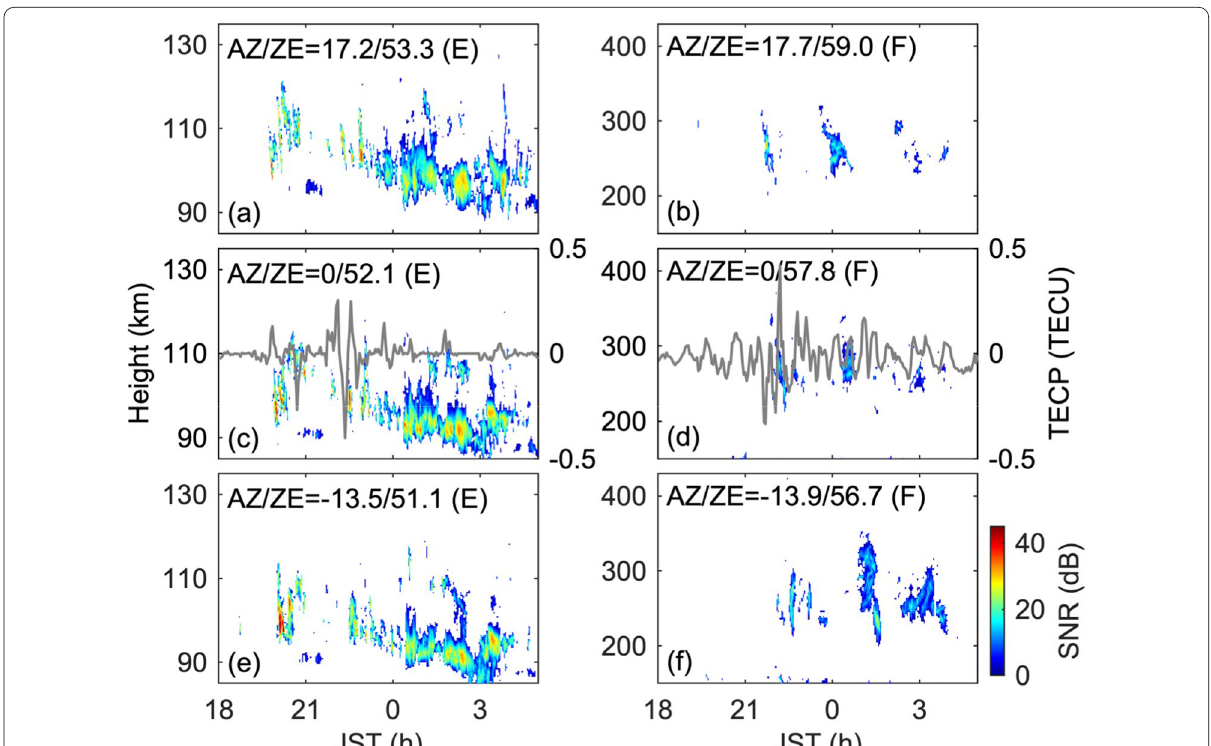
Fig. 10 Range-time-intensity plots of echo power observed with the MUR on 11 June 2007 (DOY 162). AZ and ZE represent azimuth and zenith of the transmission beams, respectively, the gray solid lines represent the mean variation of TECPs in the radar observation